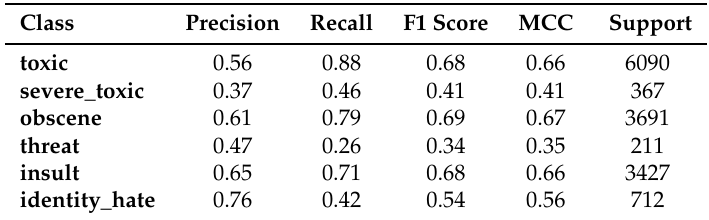
Table 15. Results of the individual toxicity classes of biLSTM + CNN model with pre-trained GloVe Twitter embeddings without standard pre-processing. Class Precision Recall